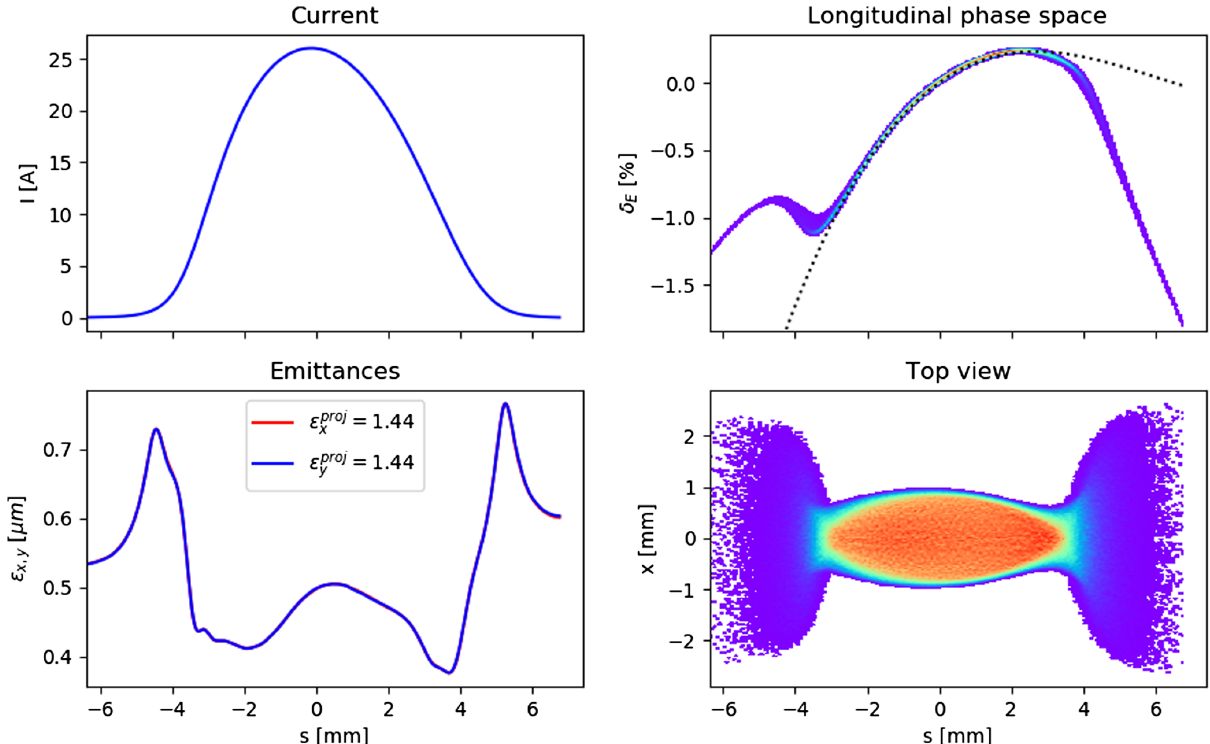
IV.FIG. 3. The properties of the bunch with a charge of 500 pC at distance z ¼ 3 . 2 m from the cathode of the rf gun. The dotted line corresponds to Eq. (1) with coefficients from Table